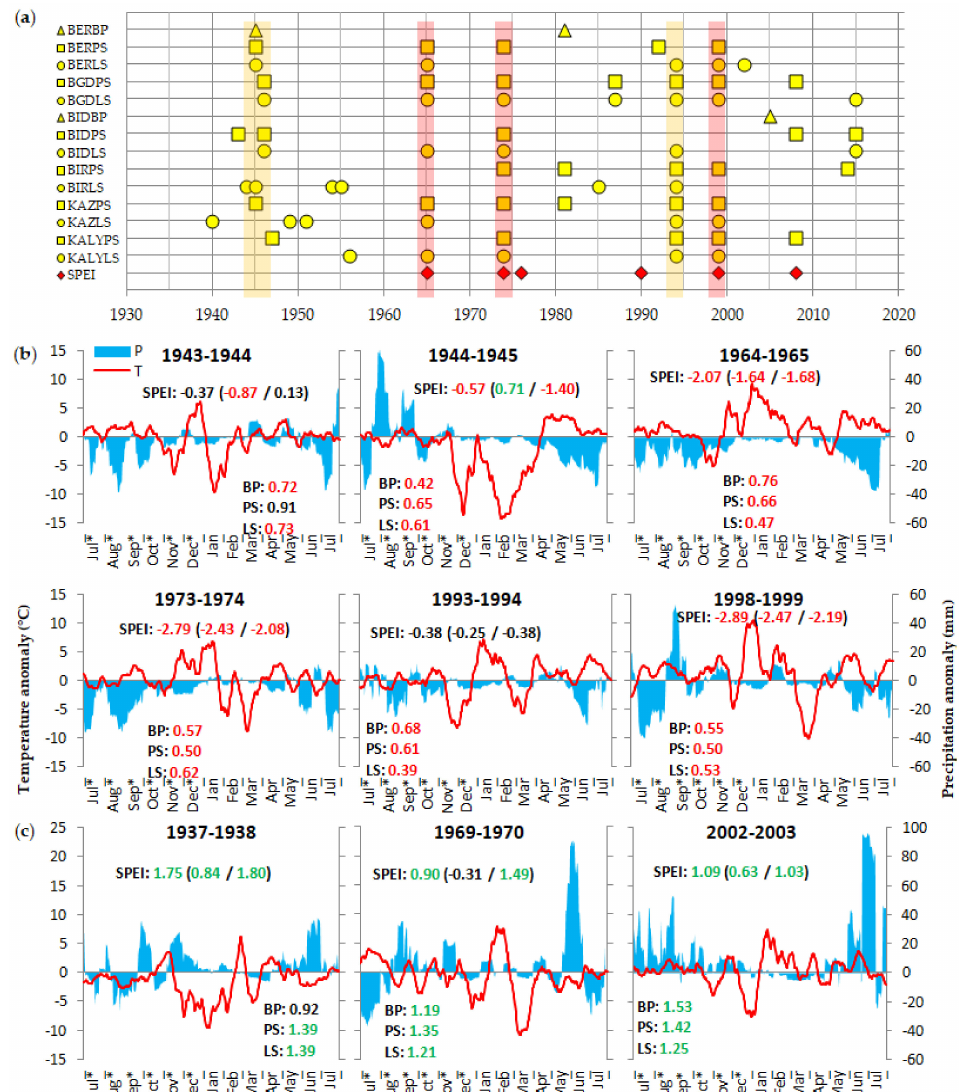
Figure 3. Pointer year analysis (1936–2018): ( a ) pointer years in tree-ring width (TRW) chronologies of Betula pendula Roth. (BP; triangles), Pinus sylvestris L. (PS; rectangles), and Larix sibirica Ledeb. (LS; circles), and full-season droughts (diamonds), defined, respectively, as TRW and total seasonal SPEI (previous July–September and current April–July) values below ( mean –1.5 SD ). ( b ) Anomalies (differences between climatic dynamics of current biological year and average curve for 1936–2018) of temperature (T) and precipitation (P) series smoothed from Minusinsk station daily data by the 21-day moving average for pointer years; ( c ) the same for years of the most optimal tree growth. Numbers on plots represent values of SPEI: total (previous season/current season); all standardized to SD = 1) and average TRW index per species for the respective biological year. * months of the previous calendar